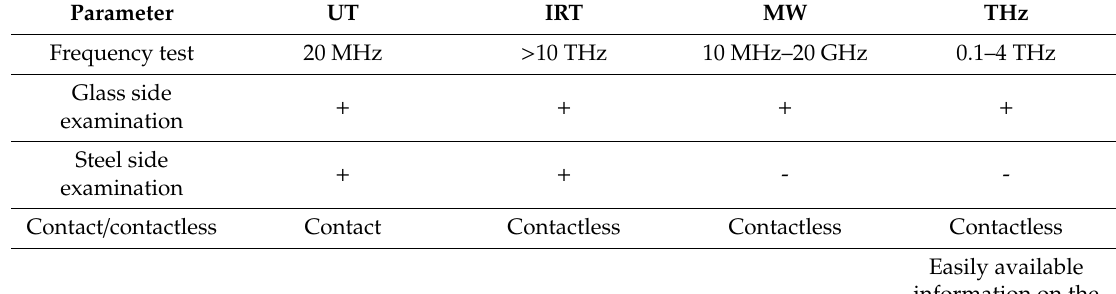
Table 2. Comparison of the individual